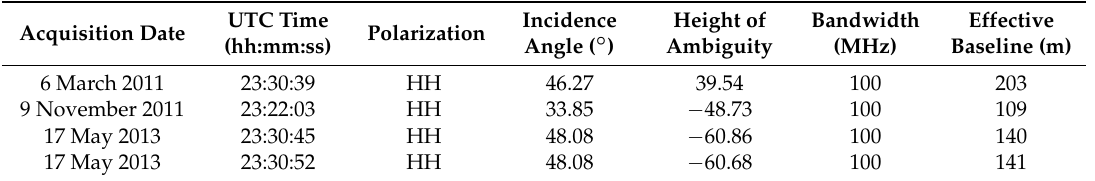
Table 2. TanDEM-X (TDX) scenes acquired and processed in this study.